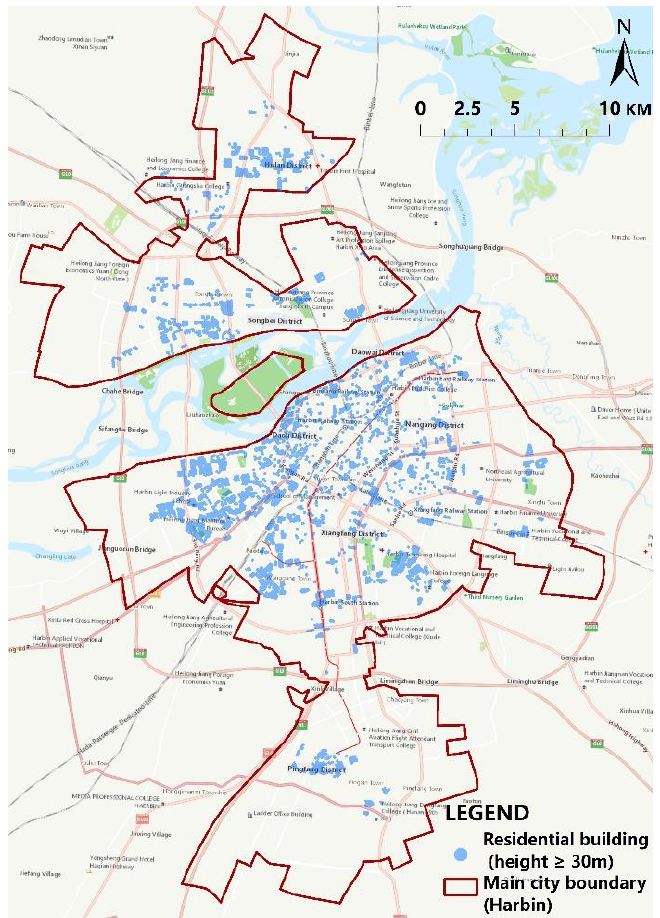
Figure 1. Harbin high-rise residential building layout map.